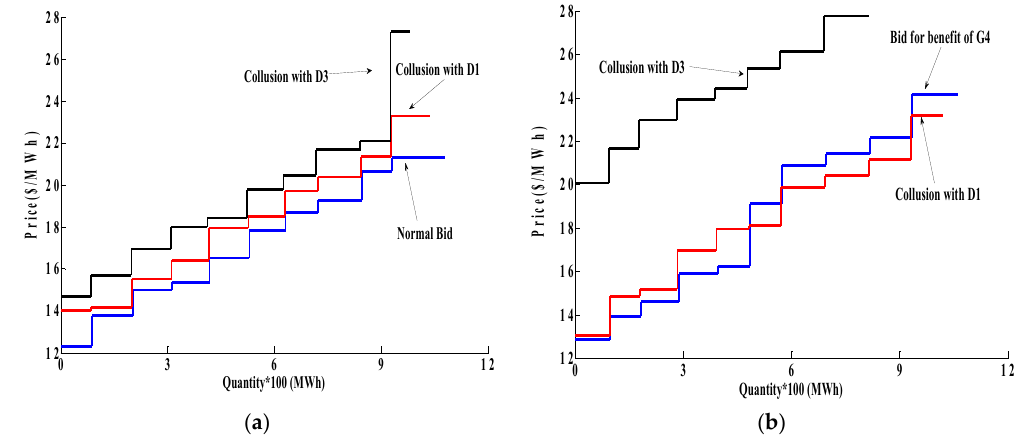
Figure 5. Bids of G1 as per Case A: ( a ) When D1 remains loyal; ( b ) when D1 does not remain loyal. Energies 2017 , 10 , 2045